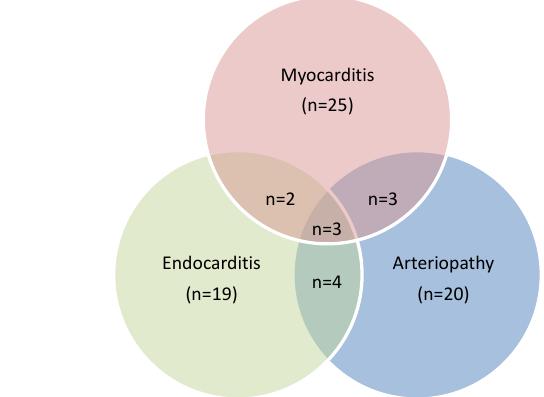
Figure 1. Occurrence and combination of classical major cardio- vascular (CV) findings in SIV-infected rhesus macaques ( Macaca mulatta ) ( n =